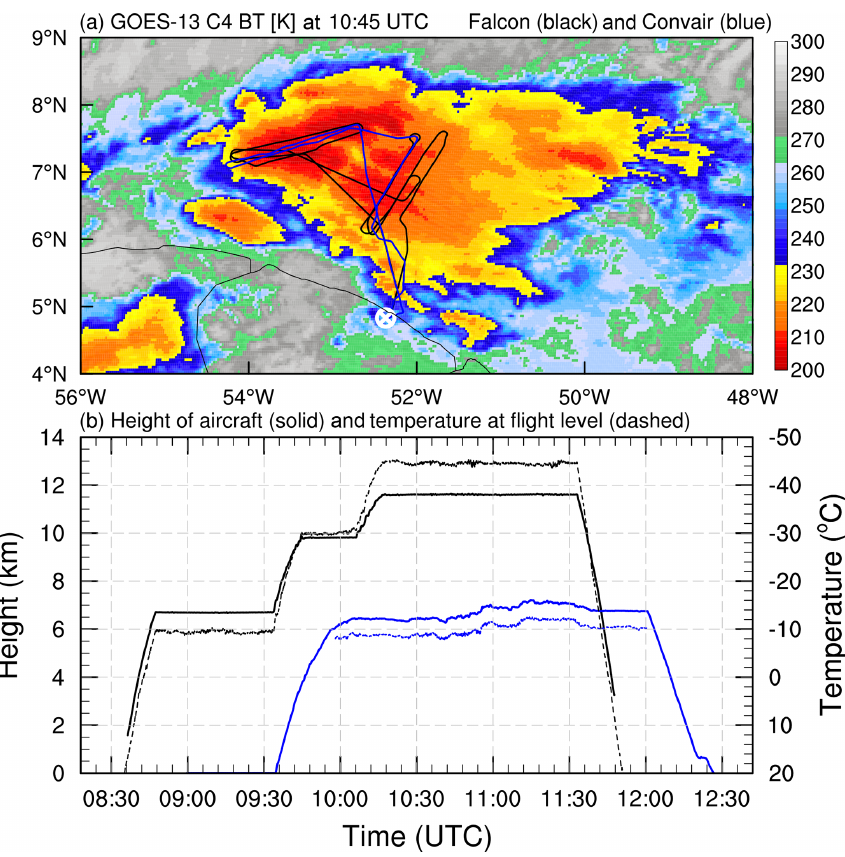
Figure 1. (a) Observed brightness temperature (K, shaded) from GOES-13 geostationary satellite channel 4 (10.8µm) at 10:45UTC on 26 May 2015 and flight tracks of SAFIRE Falcon 20 (black thick line) and NRC Convair 580 (blue thick line). (b) Height (km, thick solid curves) of aircraft above mean sea level and air temperature ( ◦ C, thin dashed curves) at the flight level for SAFIRE Falcon 20 (black) and NRC Convair 580 (blue). The white mark “ ⊗ ” in (a) represents the location of the release of a radiosonde at